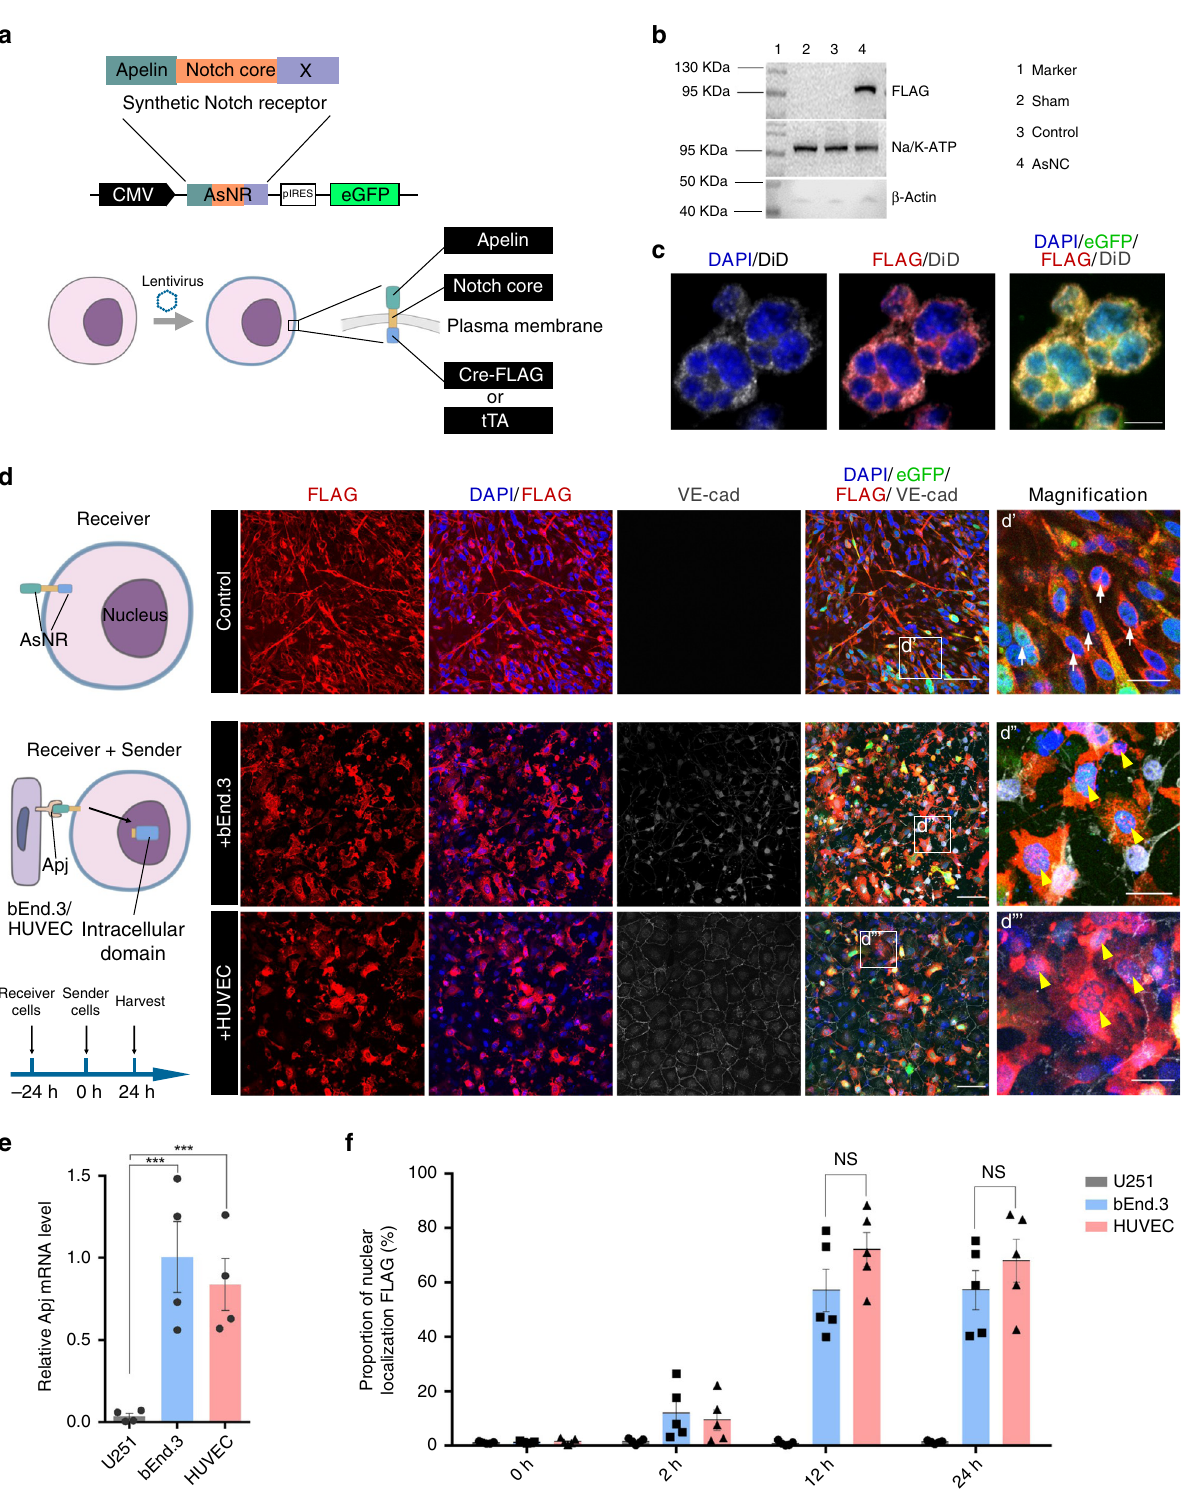
Fig. 1 Engineered cells with AsNRs can sense Apj + endothelial cells. a Strategy for generating apelin-based synNotch receptors (AsNRs). A human N- terminal CD8a signal peptide for membrane targeting and intracellular domain (X) contain cre-FLAG and tTA. b . Western blot analysis results showing a comparison of FLAG-tag levels on the plasma membrane (intracellular domain: cre-FLAG). c Immunostained GFP, FLAG, and DiD (membrane) showing that the intracellular domains were colocalized with the membrane but not the nucleus. d Immunostained GFP, FLAG, and VE-cad showing that the intracellular domains entered the nucleus (yellow arrowheads) after the receiver cells contacted the sender cells (bEnd.3 cells and HUVECs). e qPCR analysis results showing that Apj was highly expressed in both the bEnd.3 cells and HUVECs compared with Apj expression in the U251 cells. VE-cad is a marker of endothelial cells ( n = 4 wells per group). f Proportion of intracellular domains entering the nucleus, which showed that cell – cell contact was made within 12h of sender cell delivery. ( n = 5 wells per group). Scale bars = 20 μ m in c , d ’ , d ” , and d ”‘ ; 100 μ m in d . Error bars: SEM. Signi fi cance determined by Student ’ s t -test: *** p <0.001, n.s. p